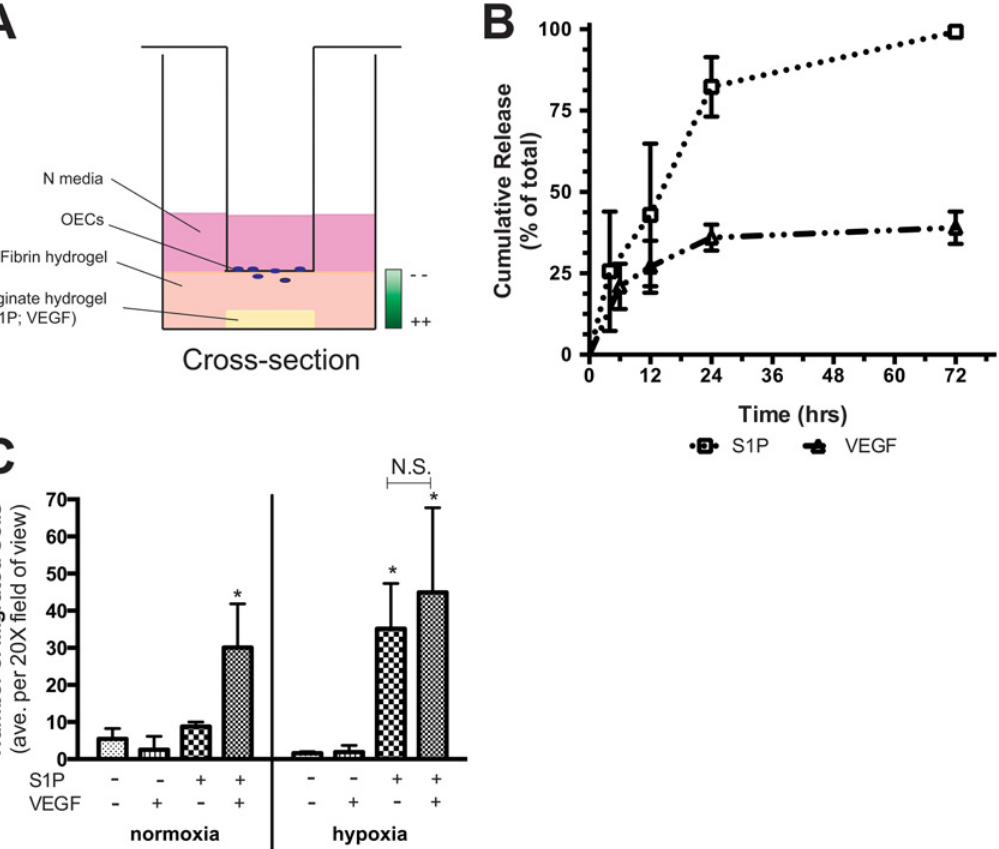
Fig 5. Hypoxic culture led to enhanced directed migration towards a gradient of S1P in vitro . A modified transwell assay was used to quantify directed migration/3D matrix invasion of OECs towards S1P in a fibrin gel (A). Gradients of S1P and VEGF were established by sustained delivery from an alginate hydrogel (B). While combined release of S1P and VEGF resulted in greater migration after 48h in both normoxia and hypoxia, S1P alone was equally sufficient under hypoxia (C). Data are mean ± SD (n = 4). An asterisk indicates statistically significant differences (P < 0.05) between conditions in normoxia or hypoxia respectively and N.S. displays no statistically significant difference between